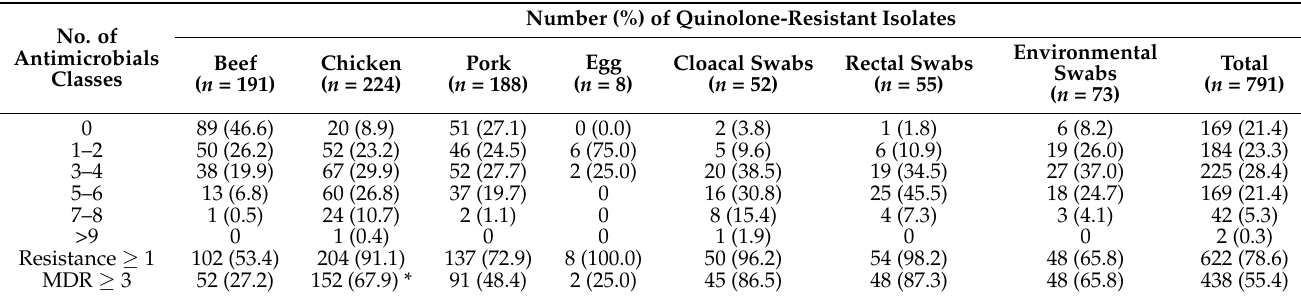
Table 3. Distribution of multidrug-resistant E. coli isolates in